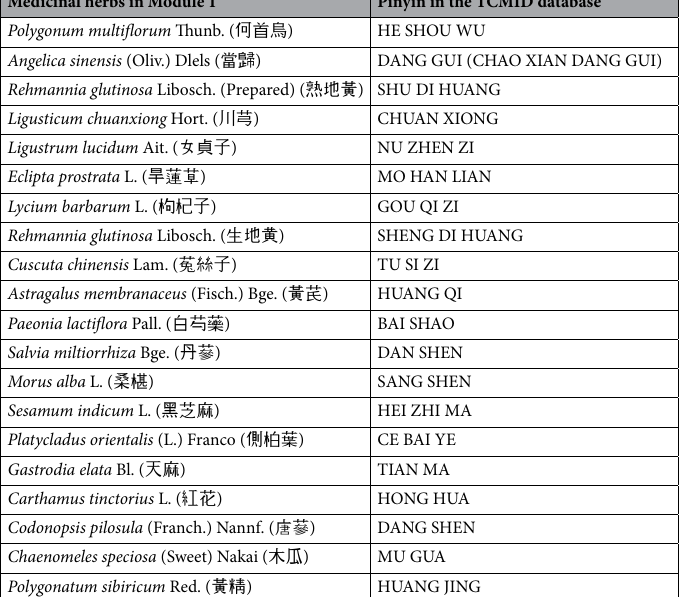
Medicinal herbs in Module